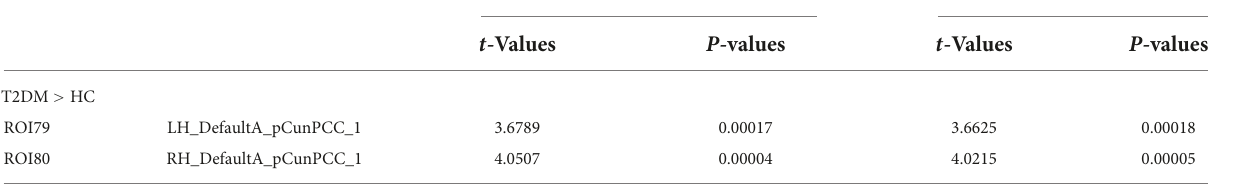
TABLE 2 Comparison of node properties differences between the T2DM and HC groups. Brain regions Nodal degree centrality Nodal efficiency t